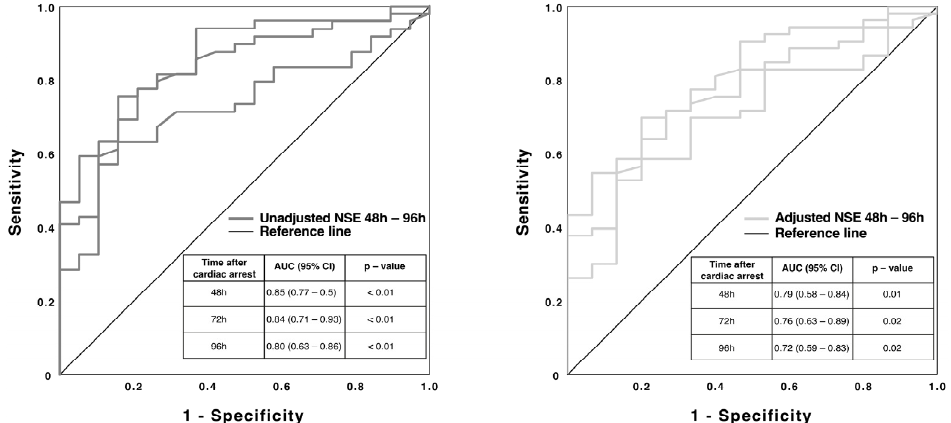
Figure 5. ROC curves of unadjusted NSE ( left image) and adjusted NSE ( right image) regarding the prediction of the two outcome groups starting 48 h after VA-ECMO initiation. ROC = receiver operating characteristics; NSE = neuron-specific enolase; AUC = area under the curve; CI = confidence interval; p = level of significance.